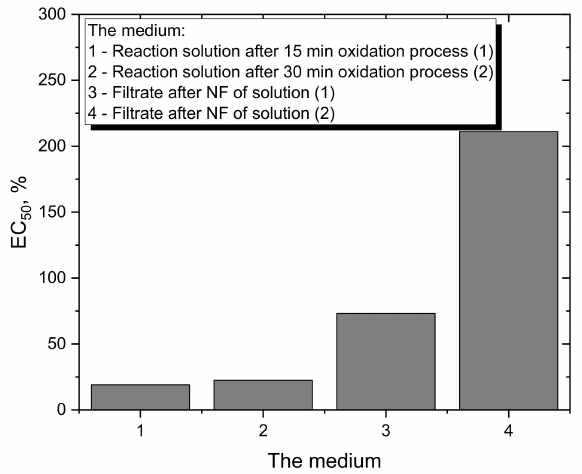
Figure 9. Toxicity tests of solution tetracycline hydrochloride (TRC) and its oxidation products (Ops) during oxidation by UV/H 2 O 2 exposition time 48